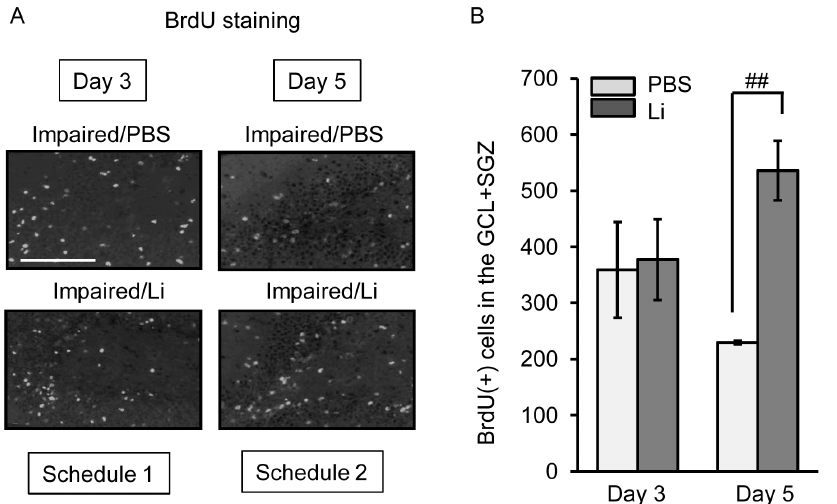
Figure 2. Effect of lithium (Li) on BrdU incorporation following neuronal loss. Animals were given either lithium carbonate (100 mg/kg, i.p.) or PBS alone with BrdU on day 2 post-treatment with TMT, and then decapitated on day 3 (Schedule 1). For Schedule 2, animals were given once a day either lithium carbonate (100 mg/kg, i.p.) or PBS on days 3 and 4, and then decapitated on day 5 post-TMT treatment. The sagittal hippocampal sections were then stained with anti-BrdU antibody. ( a ) Fluorescence micrographs show BrdU( + ) cells in the dentate gyrus of the 2 groups (impaired/ PBS, impaired/Li) on days 3 and 5 post-TMT treatment. Scale bar=100 m m ( b ) The graph denotes the number of BrdU( + ) cells in the GCL + SGZ of each group. Values are expressed as the mean 6 S.E., calculated from 5 animals. ## P , 0.01, significant difference between the values obtained for PBS and